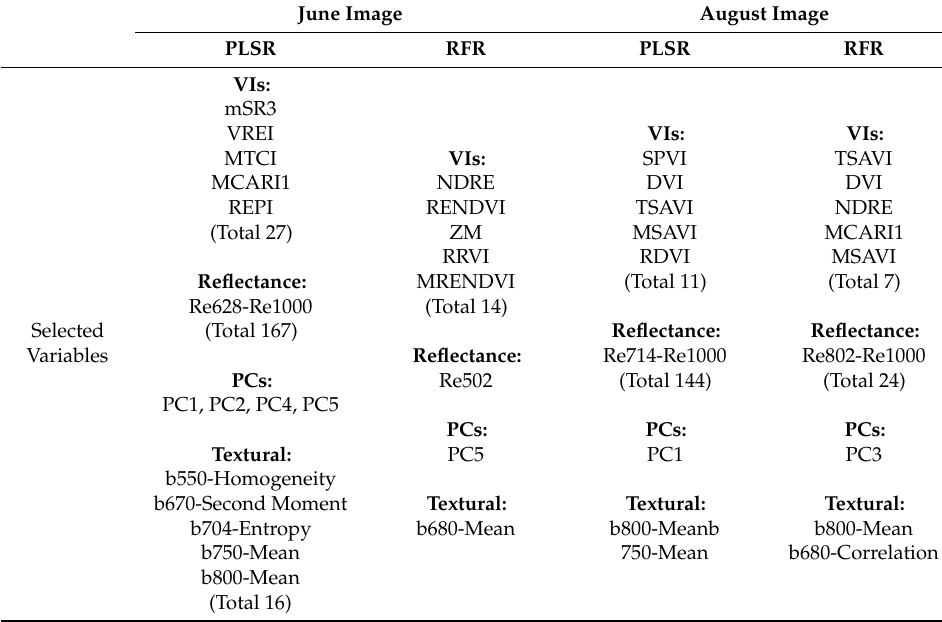
Table 2. Selected variables in the optimal partial least square regression (PLSR) and random forest regression (RFR) for June and August images, respectively. Variables are grouped by types (e.g., vegetation indices (VIs), PCs). If a large number of variables of one type were selected, only the top five (e.g., with the highest importance in the model) are listed as